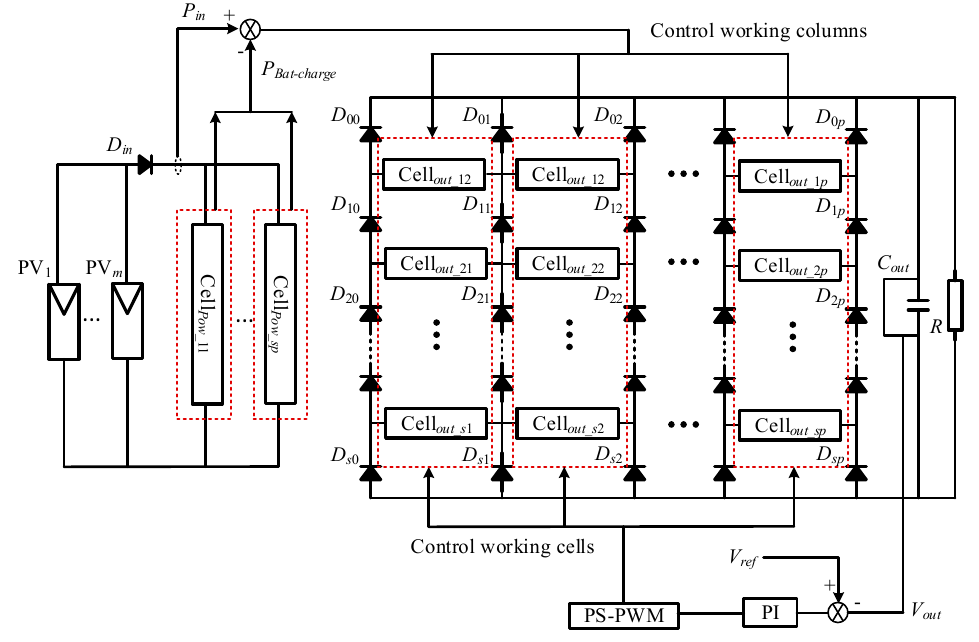
Figure 9. Control scheme of the s × p topology.